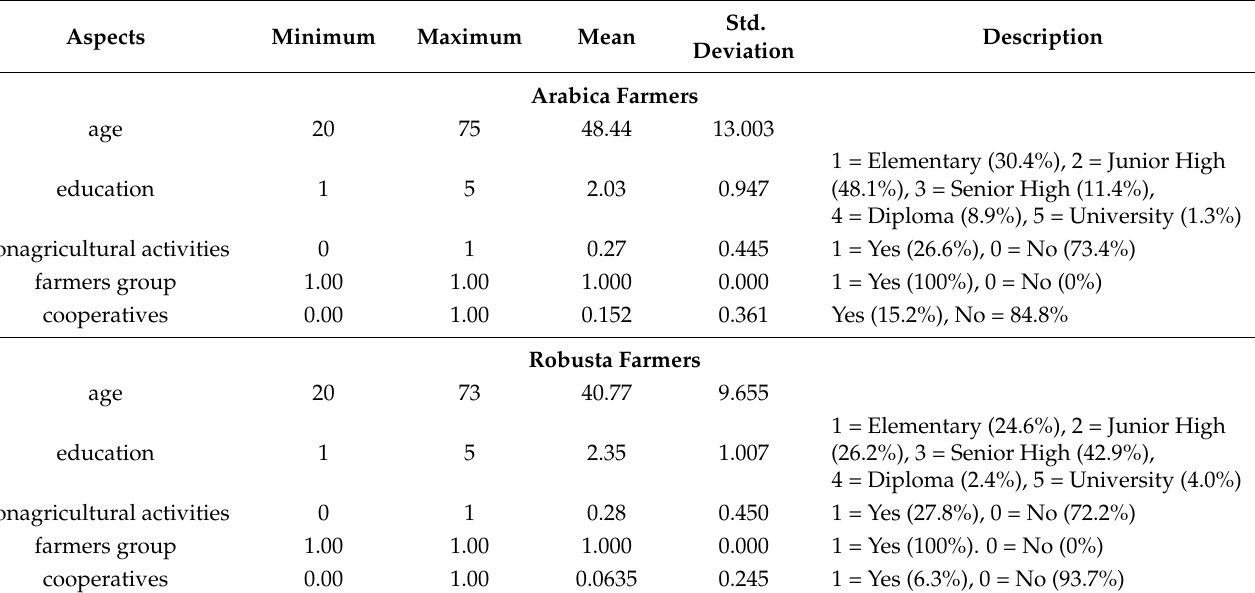
Table 2. Arabica and Robusta farmers’ household